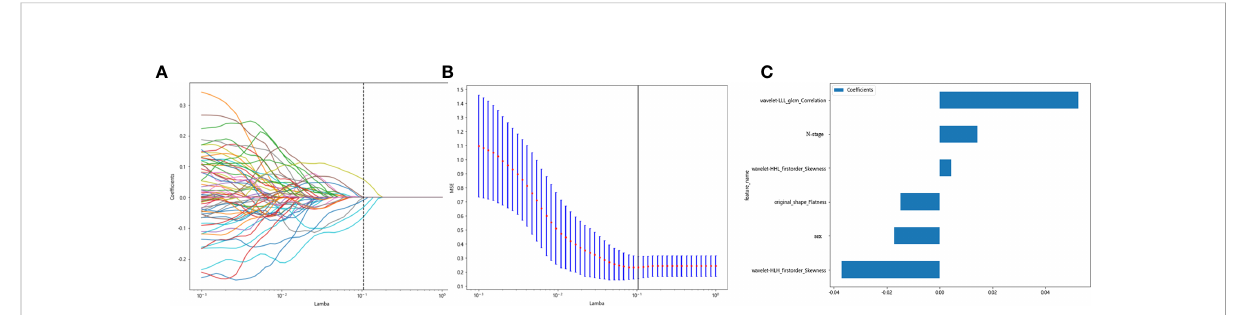
FIGURE 6 Regression feature screening. (A) Feature selection plot for the LASSO regression, which was adjusted by a super parameter (Lamba), to achieve the purpose of screening the optimal features. The vertical dashed line indicates that the corresponding optimal Lamba value when obtaining the minimum deviation value is Lamba = 0.1048. (B) The convergence graph of characteristic coef fi cients for feature selection by cross- validation. Features with non-zero coef fi cients were screened out corresponding to the vertical lines in the plot, with a total of six best features selected. (C) Features and weights of LASSO regression screening. The six features screened by LASSO were “ original_shape_Flatness, ” “ wavelet-HHL_ fi rstorder_Skewness, ” “ wavelet-HLH_ fi rstorder_Skewness, ” “ wavelet-LLL_glcm_Correlation, ” “ gender, ” and “ N_stage ”